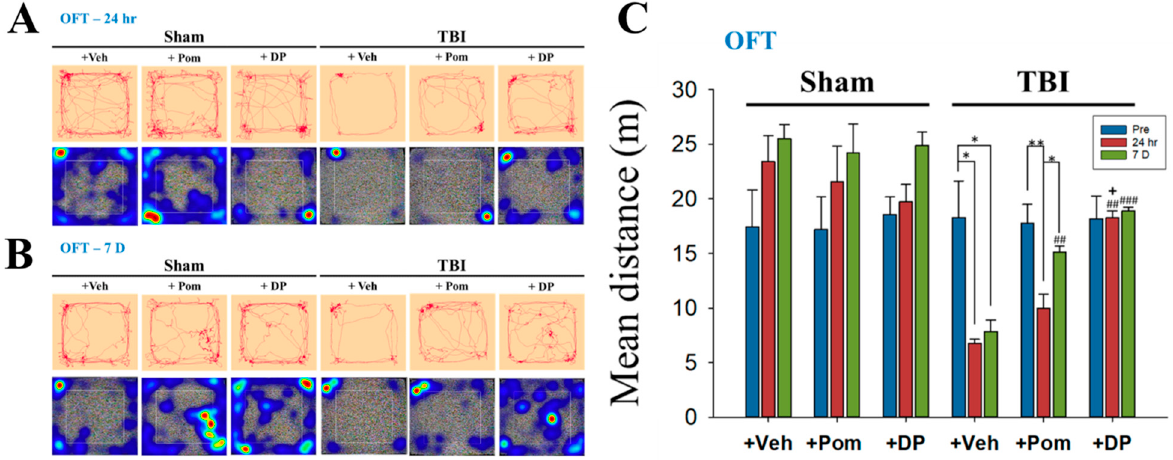
Figure 3. DP or Pom significantly improved TBI-induced anxiety-like behavior at 7 days, with the DP group showing the earlier onset of anxiety amelioration within 24 h after TBI. Representative traces and heatmaps of rat movements during the performance of OFT at 24 h ( A ) and 7 days ( B ) after TBI. On the heatmaps, the places where the rat stayed longer is shown in red. ( C ) The mean overall distance traveled at different time points in the Sham + Veh, Sham + Pom, Sham + DP, TBI + Veh, TBI + Pom and TBI + DP groups. Data are expressed as the mean ± SEM. * p < 0.05, ** p < 0.01 versus different time points in the same group; ## p < 0.01, ### p < 0.001 versus TBI + Veh group at the same time point; + p < 0.05 versus TBI + Pom group at the same time point ( n = 5 in each group). Statistical differences were analyzed using one-way ANOVA, followed by Tukey’s post hoc comparisons.